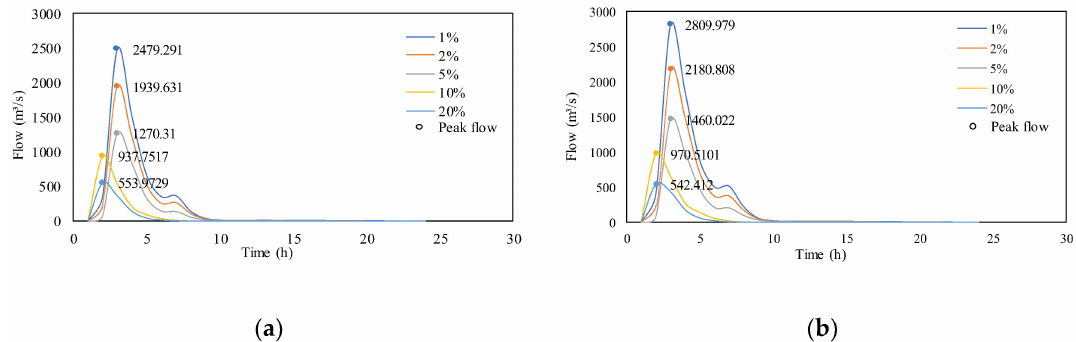
Figure 10. Design flood hydrograph gauging section: Anding ( a ), Qiangjiawan ( b ).